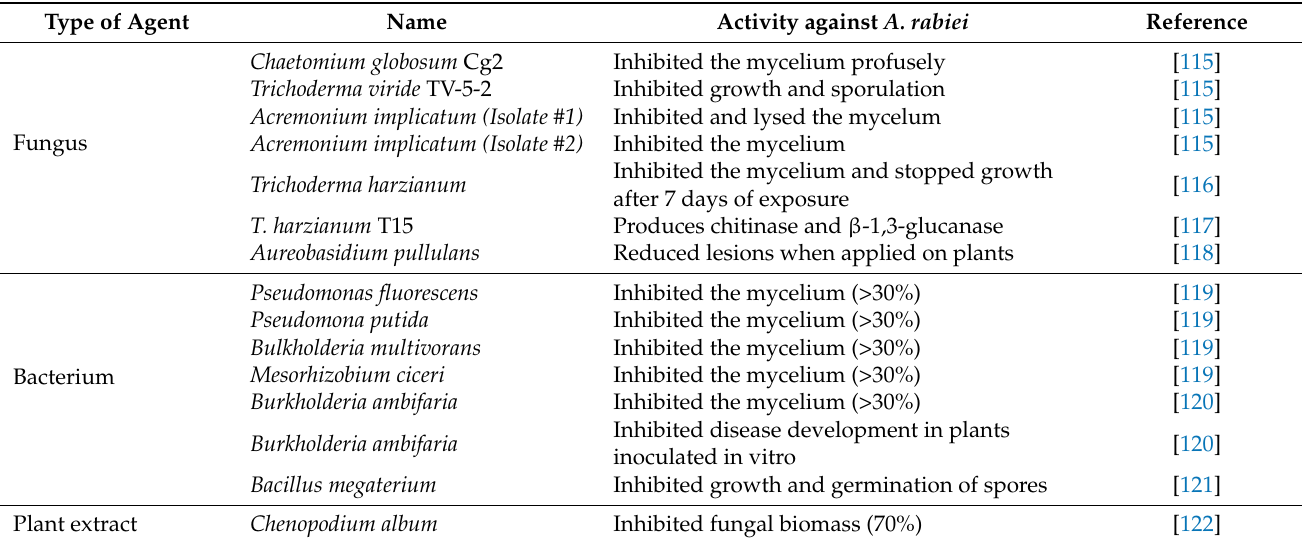
Table 1. Biological agents linked to A. rabiei inhibition